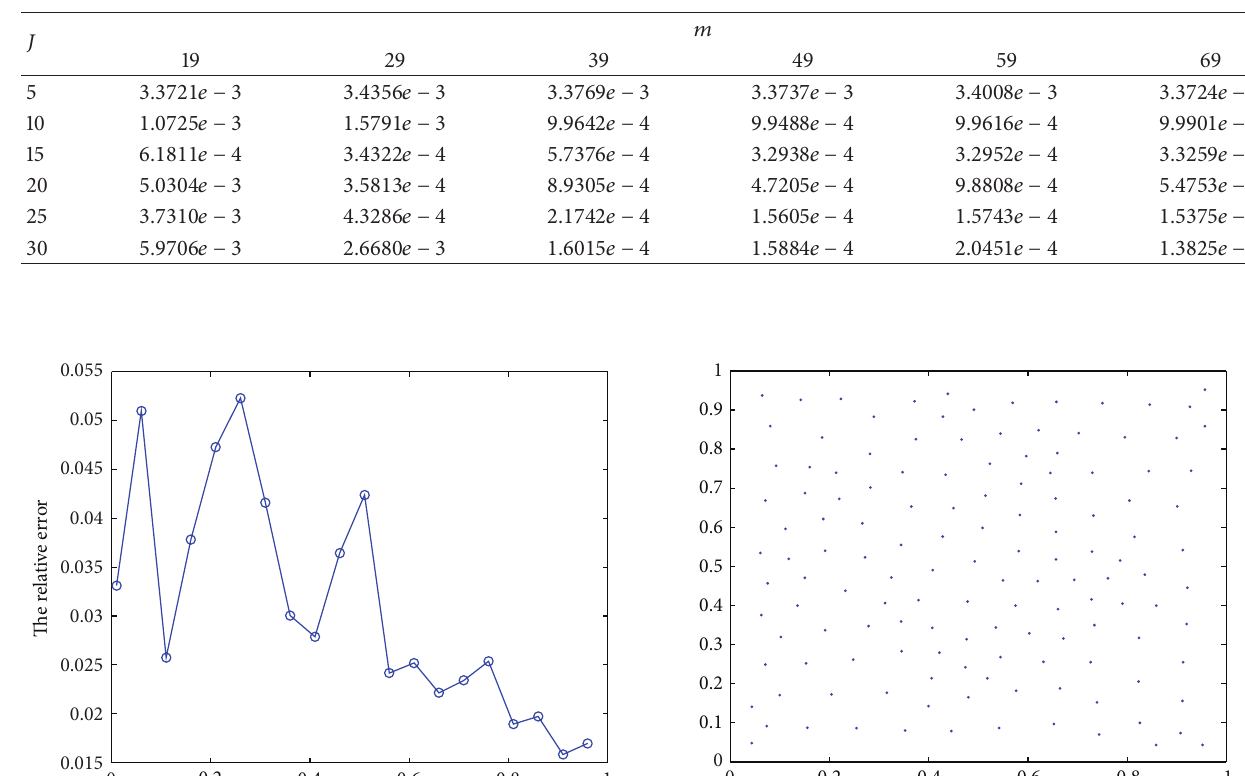
Table 2: Example 1: the relative errors with 𝑡 0 = 1𝑒 − 10 , 𝑁 = 59 , and 𝜖 = 0 %.